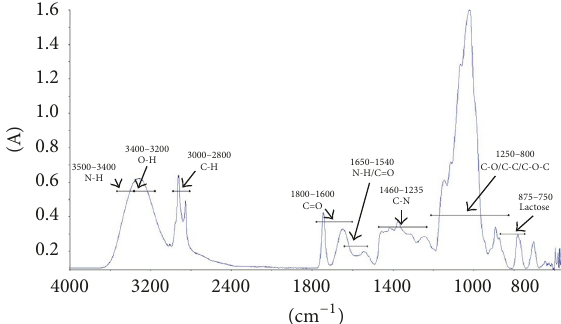
Figure 1: Mid-FTIR spectrum of infant formula